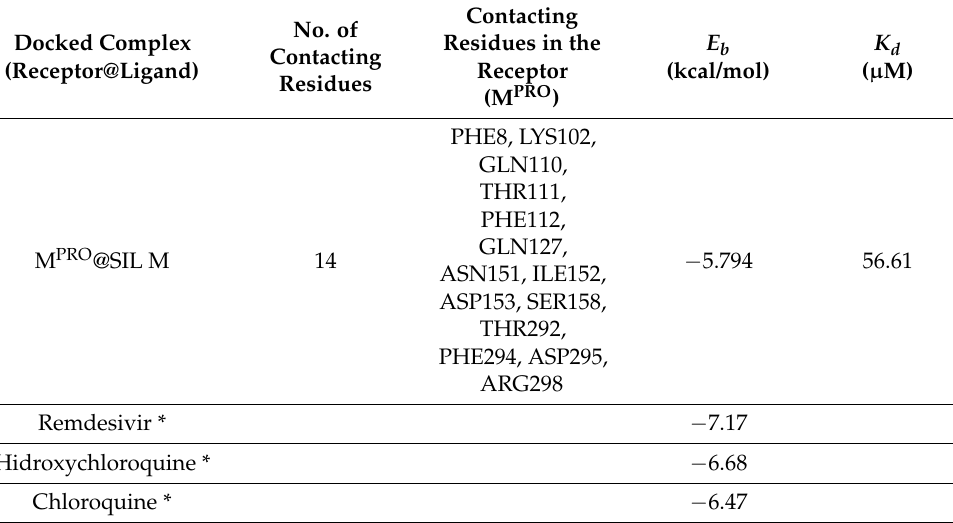
Table 7. Contacting receptor residues by ligand in docked complex M PRO @SIL-M, and calculated affinity estimators (relative binding energy and dissociation constant).